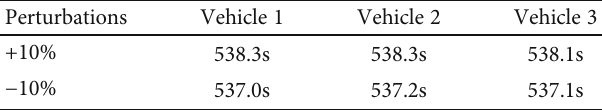
Table 5: Terminal times of aerodynamic parameter